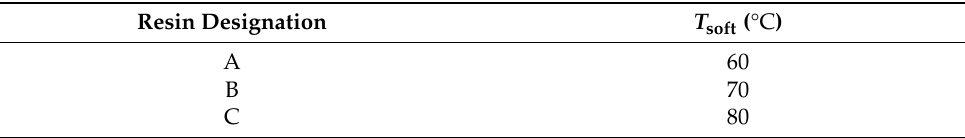
Table 1. Characterization of the resins used in the experimental